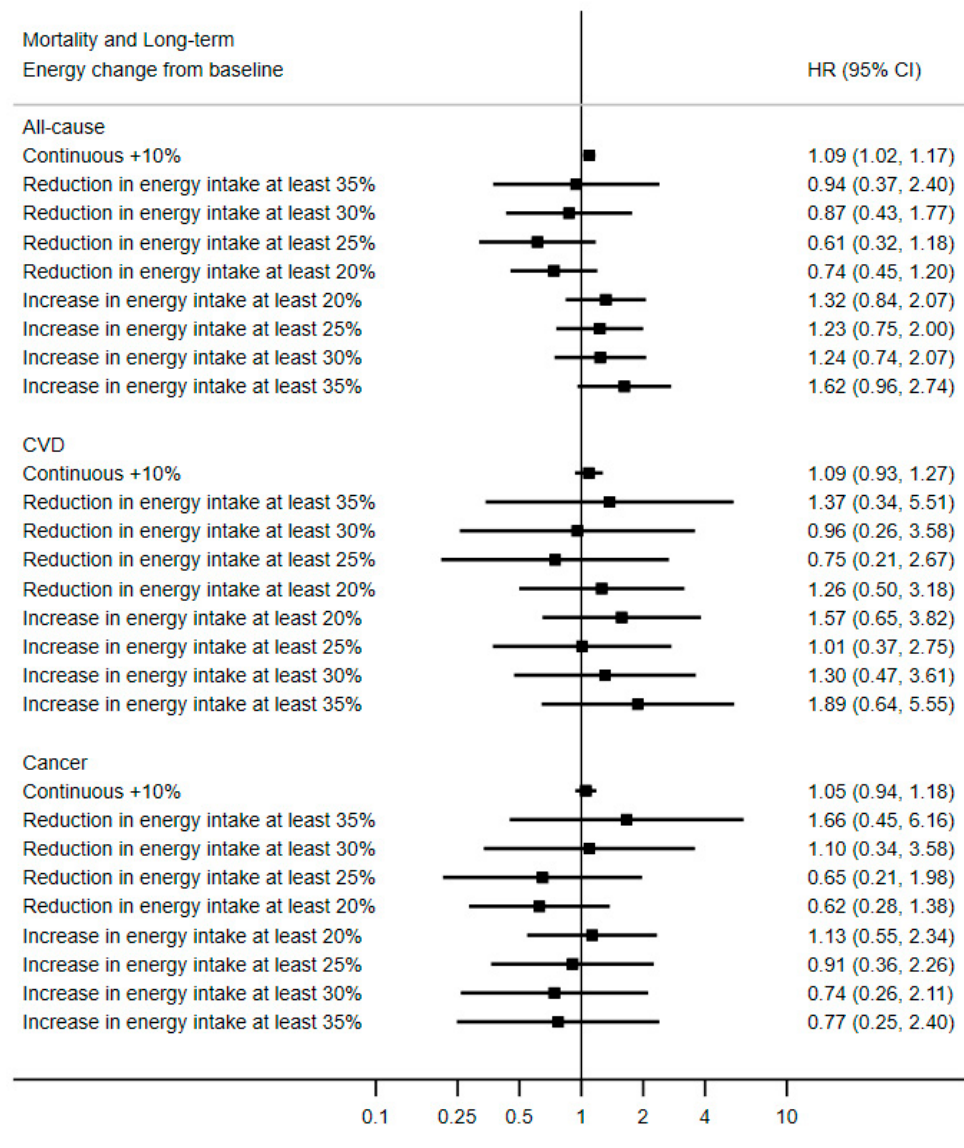
Figure 3. Association between long-term change in energy intake compared to baseline and mortality, PREDIMED Study, N = 6180. Values are multivariable hazard ratios (HRs) and 95% confidence intervals, stratified by sex, study center and education level, and adjusted for baseline age, intervention group, hypertension, hypertriglyceridemia, hypercholesterolemia, diabetes, alcohol intake, smoking status and cumulative average of Mediterranean diet score, baseline physical activity and body mass